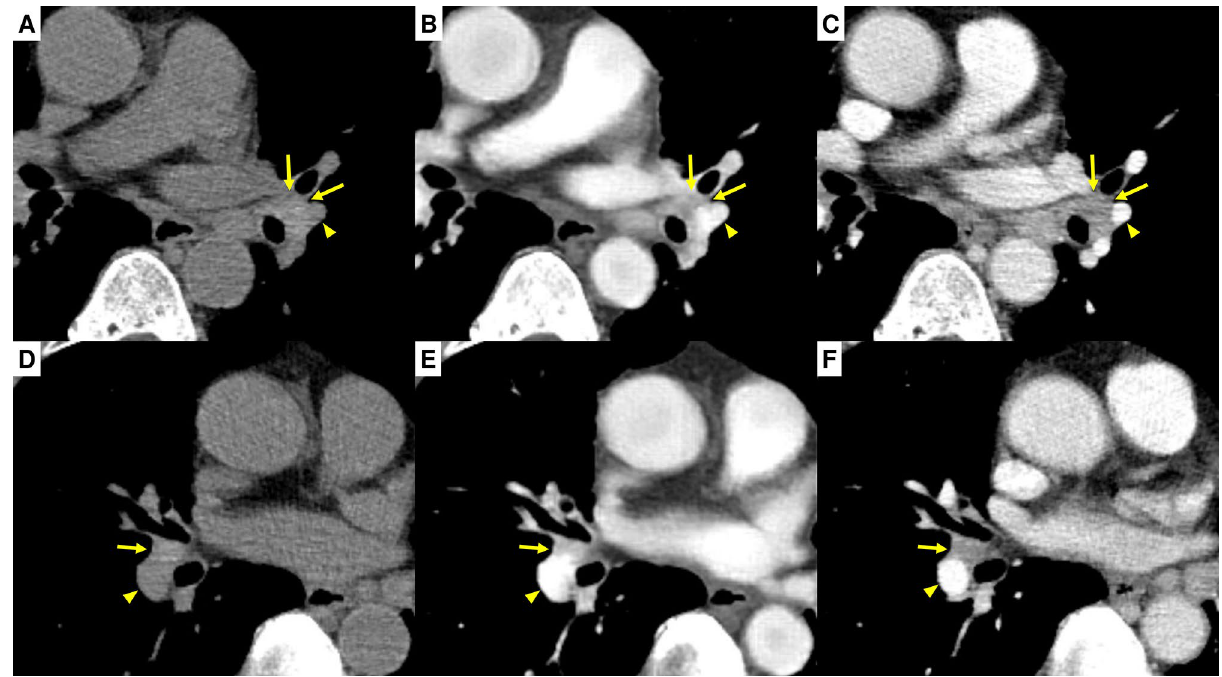
Figure 5. Images of a 78-year-old man with lung cancer and multiple mediastinal lymph node metastases from test set 2. Non-contrast CT ( A , D ), synthetic contrast-enhanced CT ( B , E ), and contrast-enhanced CT ( C , F ). Hilar lymph nodes (arrows), which are clearly visible on contrast-enhanced CT, are better distinguished from adjacent pulmonary vessels (arrowheads) on synthetic contrast-enhanced CT than on non-contrast